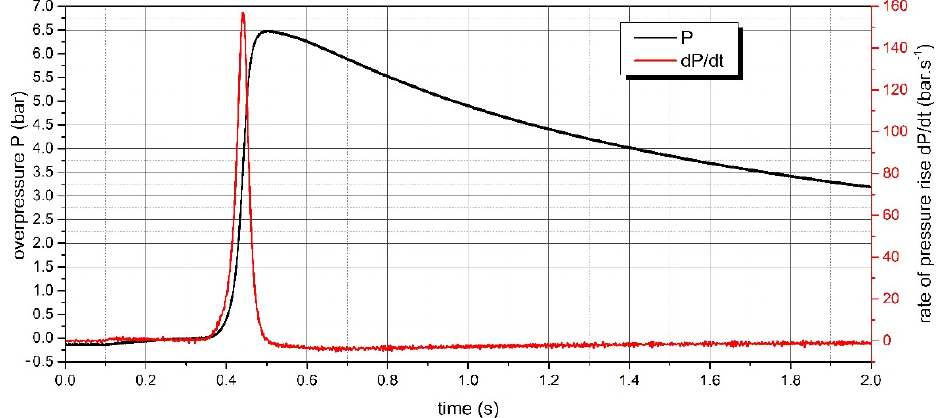
Figure 8. Pressure record of PA12 polyamide explosion at concentration 500 g·m -3 .